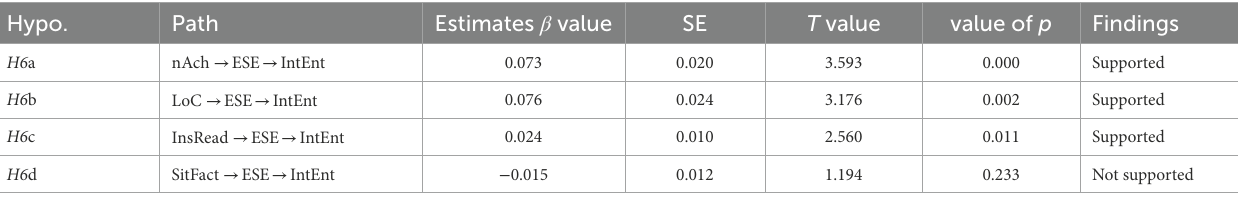
TABLE 10 Mediation effects of nAch, LoC, InsRead, and sitfact on ESE to IntEnt relationship.